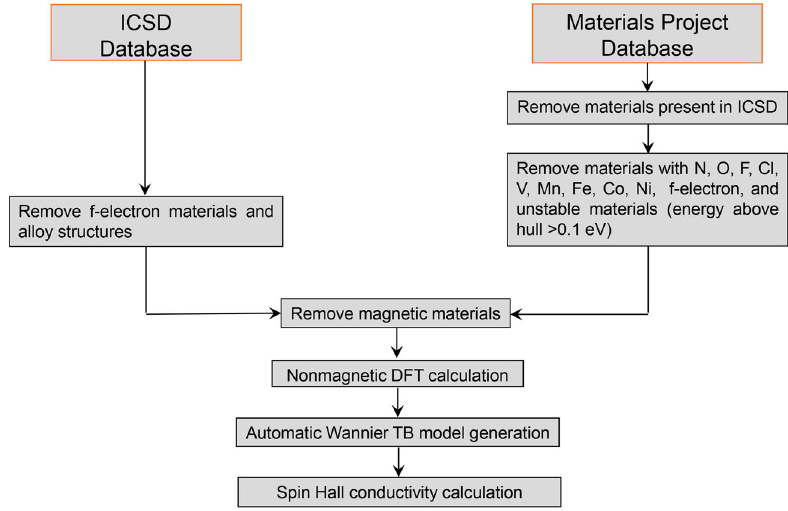
Fig. 1 Work fl ow to obtain the dataset of materials for the high-throughput calculations of intrinsic